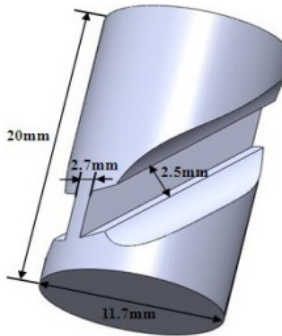
Figure 1. Schematic presentation of the shear ‐ compression specimen.